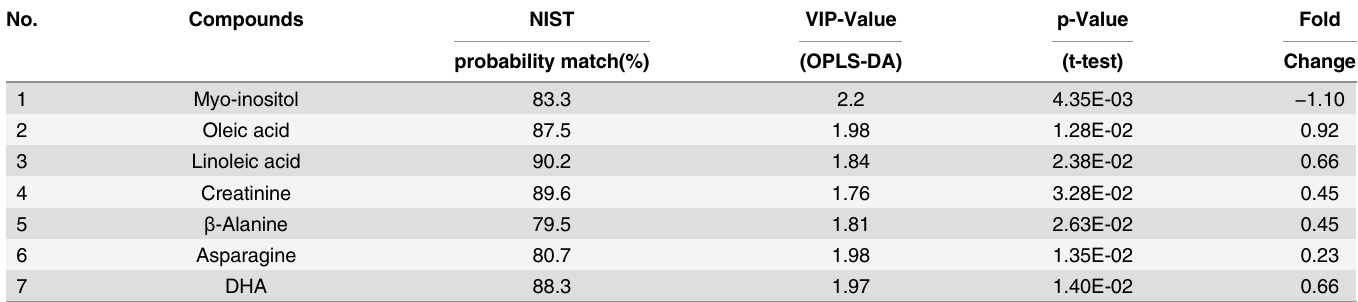
Table 1. The differential metabolites in the plasma between C3H-FB and C3H control mice. No.